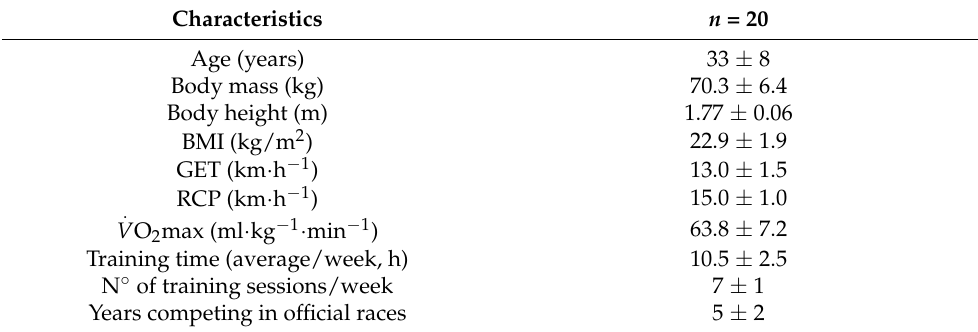
Table 1. Baseline characteristics of study participants.